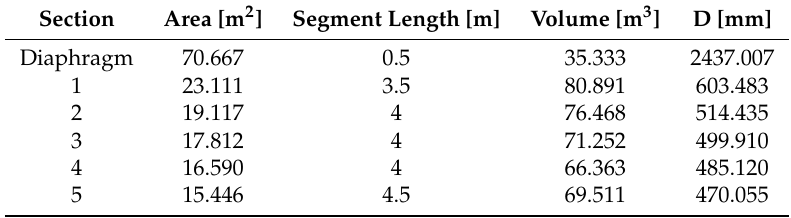
Table 4. Geometric characteristics of the bridge cross section and effective thickness, D = 2 V / S